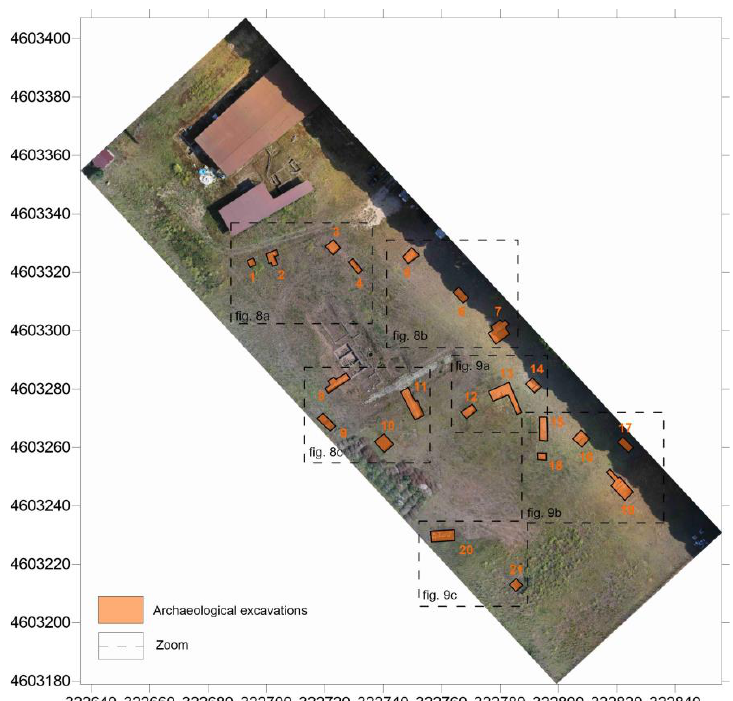
Figure 8. Archaeological excavations position to verify ground truth.